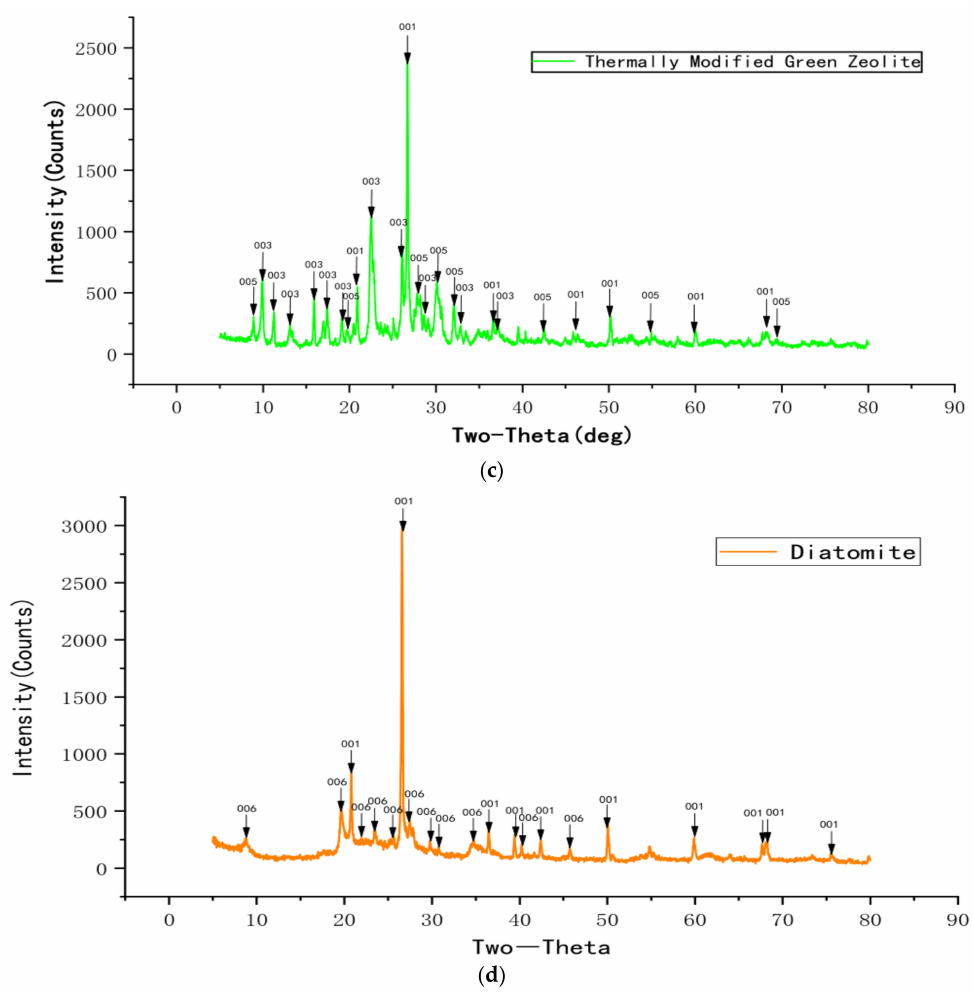
Figure 3. The XRD profiles of natural green zeolite powder ( a ), sodium chloride modified green zeolite powder ( b ), thermally modified green zeolite ( c ), and diatomite composite ( d